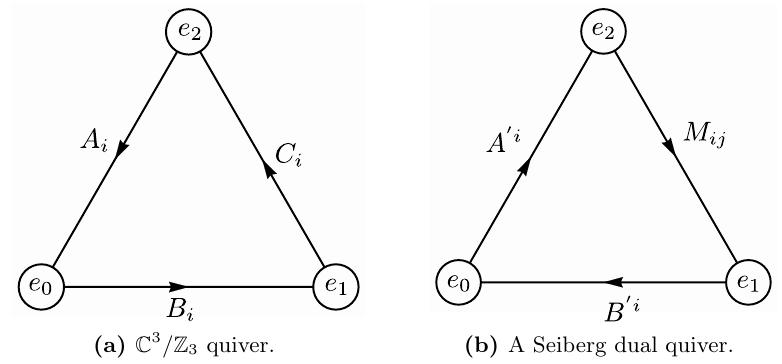
Figure 11 . The C 3 = Z 3 quiver and a Seiberg dual. The arrows A; B; C and A 0 , B 0 each have multiplicity 3, while the arrow M has multiplicity